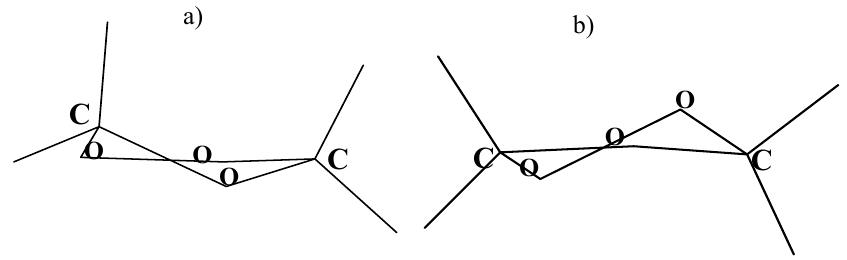
Fig. 2 Conformations of five membered ring of secondary ozonides: a) C-O half-chair conformation; b) O-O half-chair